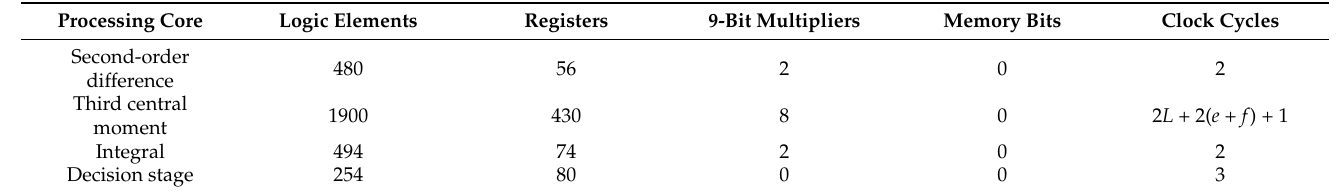
Figure 11. Architecture of the peak detector. Table 1. Usage of FPGA resources. Table 1. Usage of FPGA